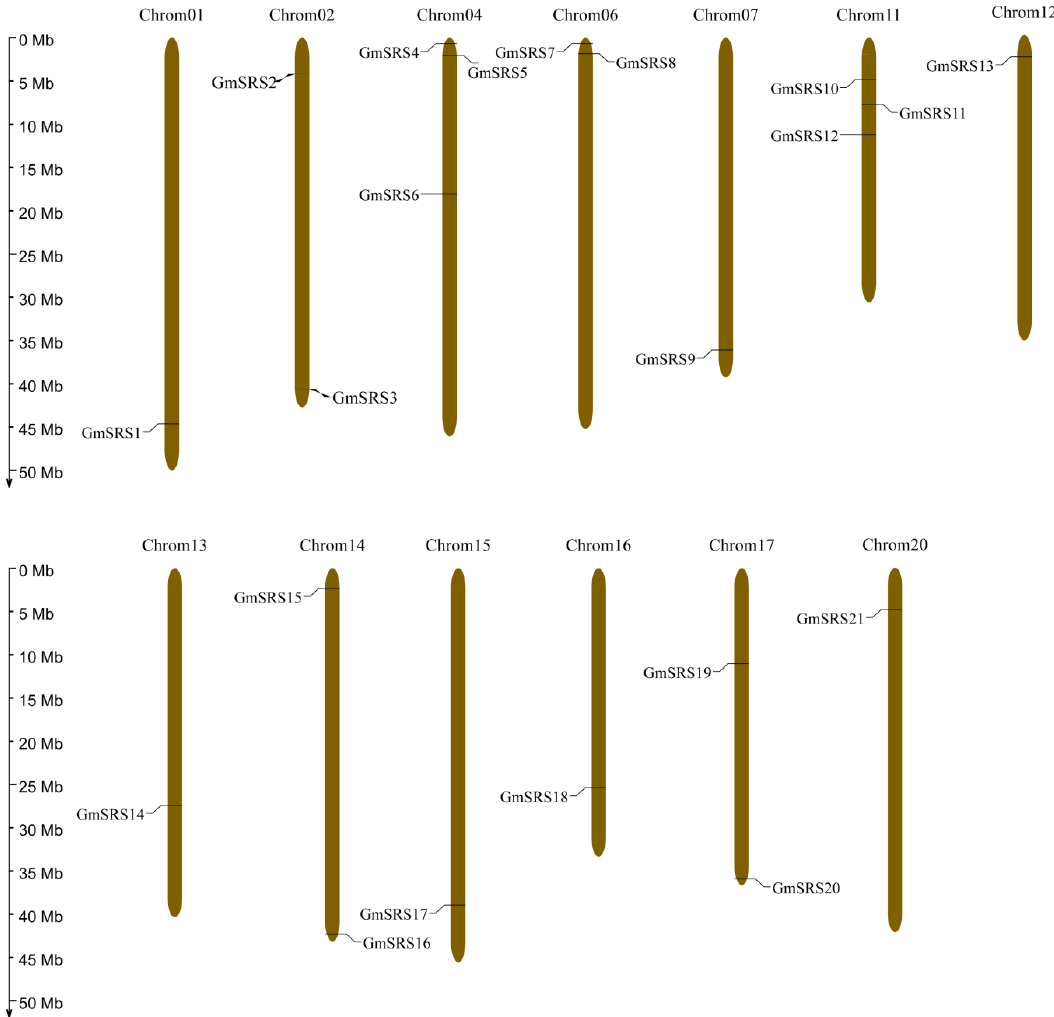
Figure 2. Chromosomal locations of soybean SRS genes. The ratio on the left represents the chromosome length.